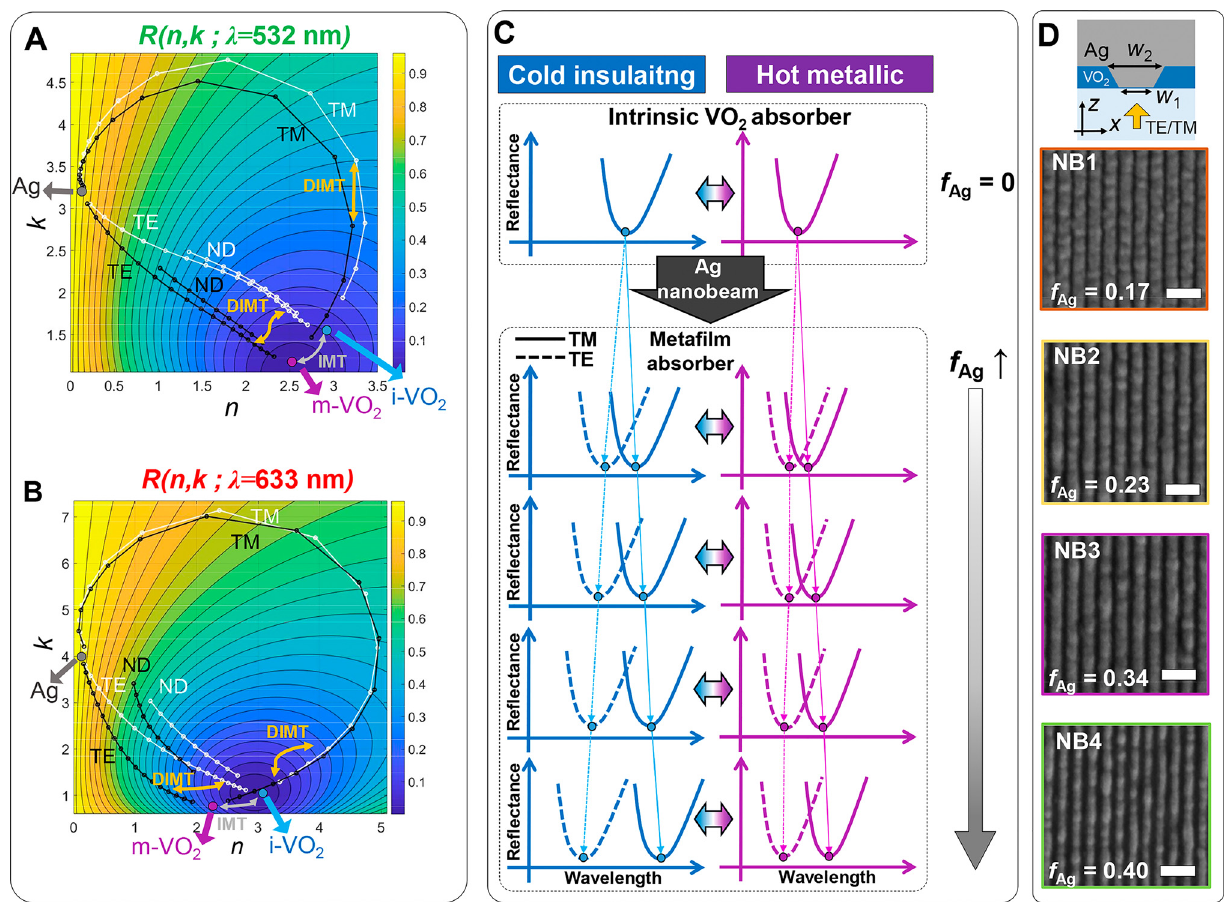
Figure 2: Design principles of anisotropic effective complex refractive indices of VO 2 meta fi lm and designed re fl ection tunability. The numerically retrieved Wiener bounds of effective refractive indices with corresponding reflectance maps at the (A) green (532 nm) and (B) red (633 nm) colors. The points marked as Ag, i-VO 2 , and m-VO 2 correspond to ( n , k ) coordinates of Ag, high index VO 2 at the insulating phase, and low index VO 2 at the metallic phase at the certain wavelengths, respectively. The white and black dotted lines denote effective refractive index coordinates with VO 2 at the insulating and metallic phases, respectively. ND in (A) and (B) implies nanodisk. The ND curves in (A) and (B) imply the VO 2 meta fi lm cases where isotropic circular Ag nanodisks are embedded in the VO 2 layer with same f Ag (= π r 2 / p 2 where r and p are radius and period of Ag nanodisks) values compared to the Ag nanobeam embedded meta fi lm absorbers. f Ag values of nanobeam and nanodisk type meta fi lms are varied from 0.05 to 0.95, and from 0.05 to 0.45, respectively. (C) Schematic illustration of intended mechanismandworkingprincipleofdynamicGires-Tornoismeta fi lmabsorbersaccordingtoperiodicphotonicdopinglevelofAgnanobeams. (D) Schematic unitcell description with sidewall tapering effect and top view SEM images of the phase-change meta fi lm absorbers (PCMAs). Scale bars denote 500